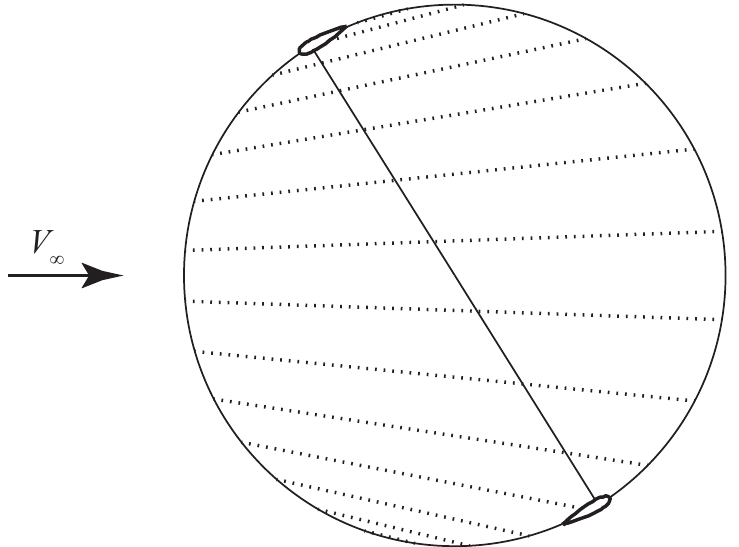
Figure 3. Streamlines through a turbine.